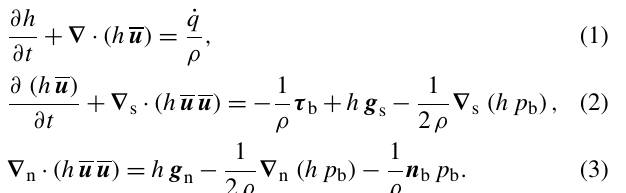
Figure 1. Definition of velocity u , flow thickness h and basal pres- sure p b on a control volume. A hydrostatic and linear pressure dis- tribution is assumed. The shape of the velocity profile is commonly ignored in governing equations (Baker et al., 2016). Flow thickness h is measured normal to the basal surface (cid:48) . The curvature radius of the surface (cid:48) is assumed to be much bigger than the flow